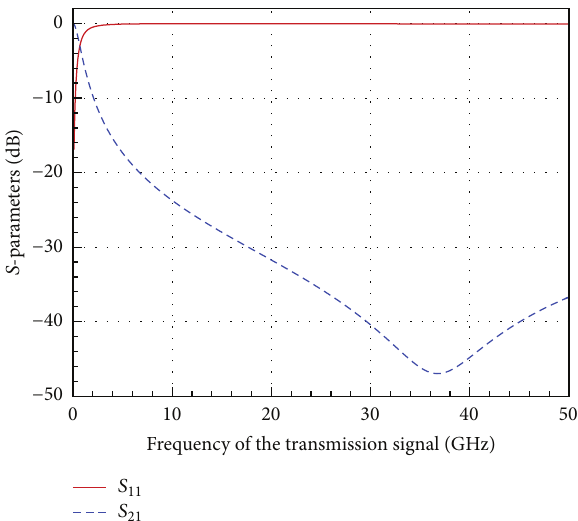
Figure 10: HFSS Simulation results of the switch in OFF